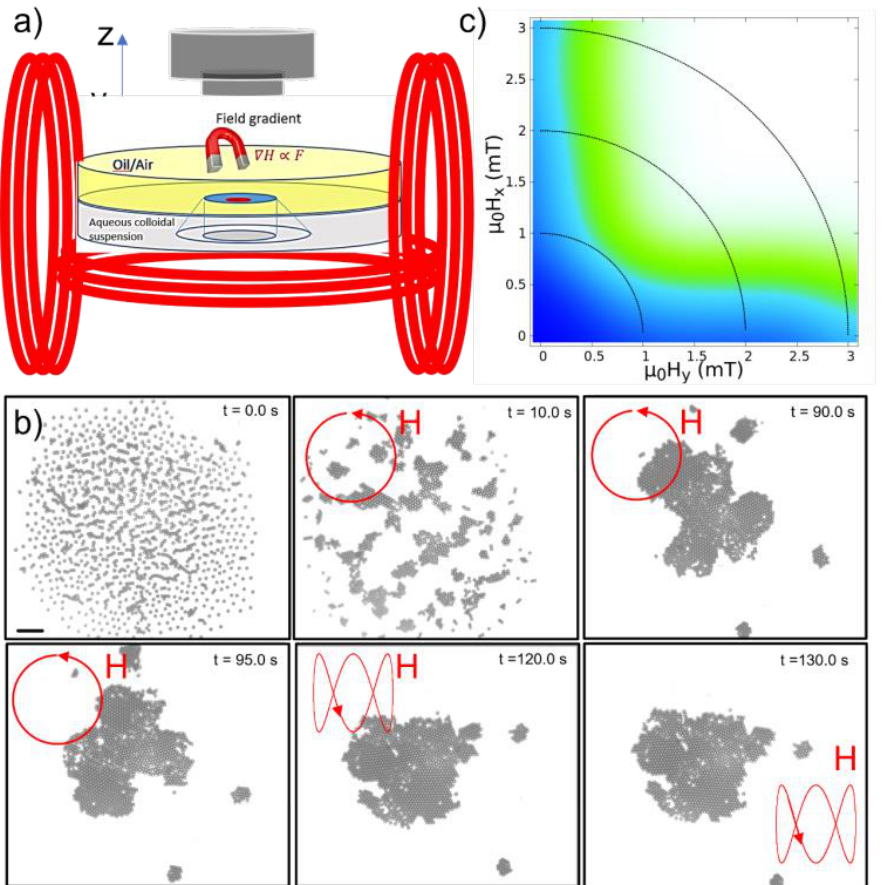
Figure 1. ( a ) Magnetic particles are attracted to a water/decane interface with the help of a magnet to facilitate the adsorption process. After the magnet is moved away, the non-adsorbed particles fall into the aqueous sub-phase, while the adsorbed particles remain in the plane of the fluid interfaces due to the relatively high value of the trapping energy. To reduce the drift motion generated by convention effects, the laden water/decane interface is confined by a hollow, non-magnetic glass cylinder. Finally, the adsorbed magnetic particles are magnetized by the field generated by a pair of coils connected in series, aligned along the X and Y axes and a fifth coil aligned along Z, the optical axis of the microscope. ( b ) The image sequence shows how the application of the high-frequency rotating field, f x = f y = 20 Hz, at the interface plane promotes a crystallization process, which, at relatively high particle densities, occurs in the range of tens of seconds. From t = 120 s, the rotating field is replaced by the combination of two fields with different frequencies, which still promotes isotropic attraction between the particles but prevents rotation of both the constituent particles and the resulting polycrystals (please, compare the images taken at t = 120 s and 130 s). Scale bar: 20 microns. ( c ) Diagram of configurations showing the regions where crystal formation is observed after application of the in-plane rotating field. The white area represents the conditions where the attraction between colloids causes the particles to form a polycrystal composed of different domains with hexagonal order. In the blue zone, the colloidal particles form linear aggregates or are scattered by the thermal noise itself, and the green zone represents the onset of the premelting zone, a transition zone between the two previous configurations. Here, the continuous lines represent constant field